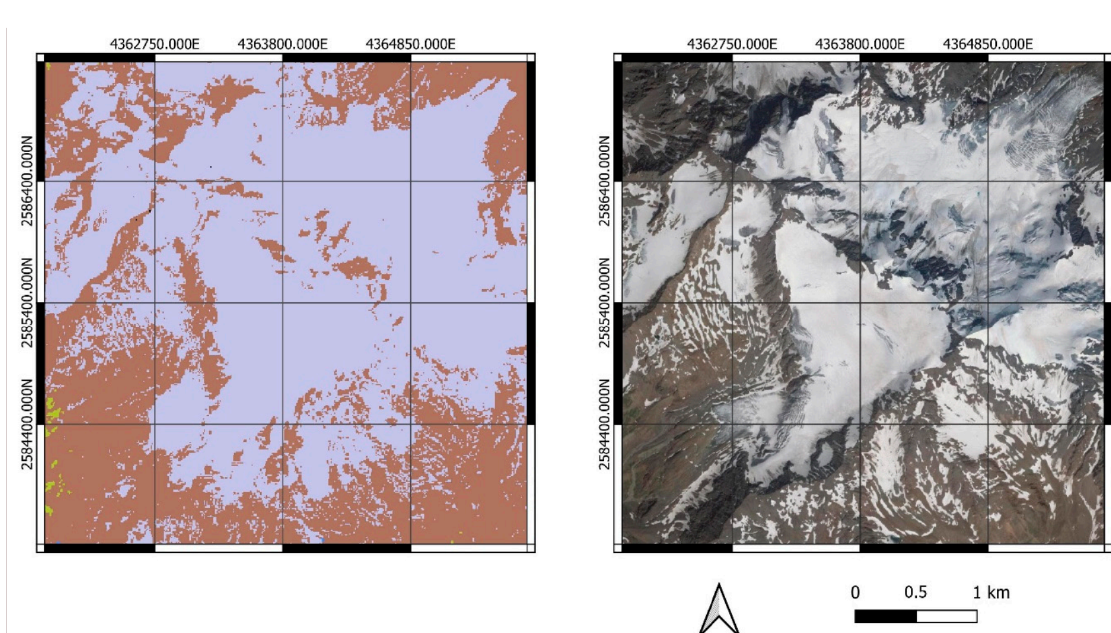
Figure 8. Permanent snow and